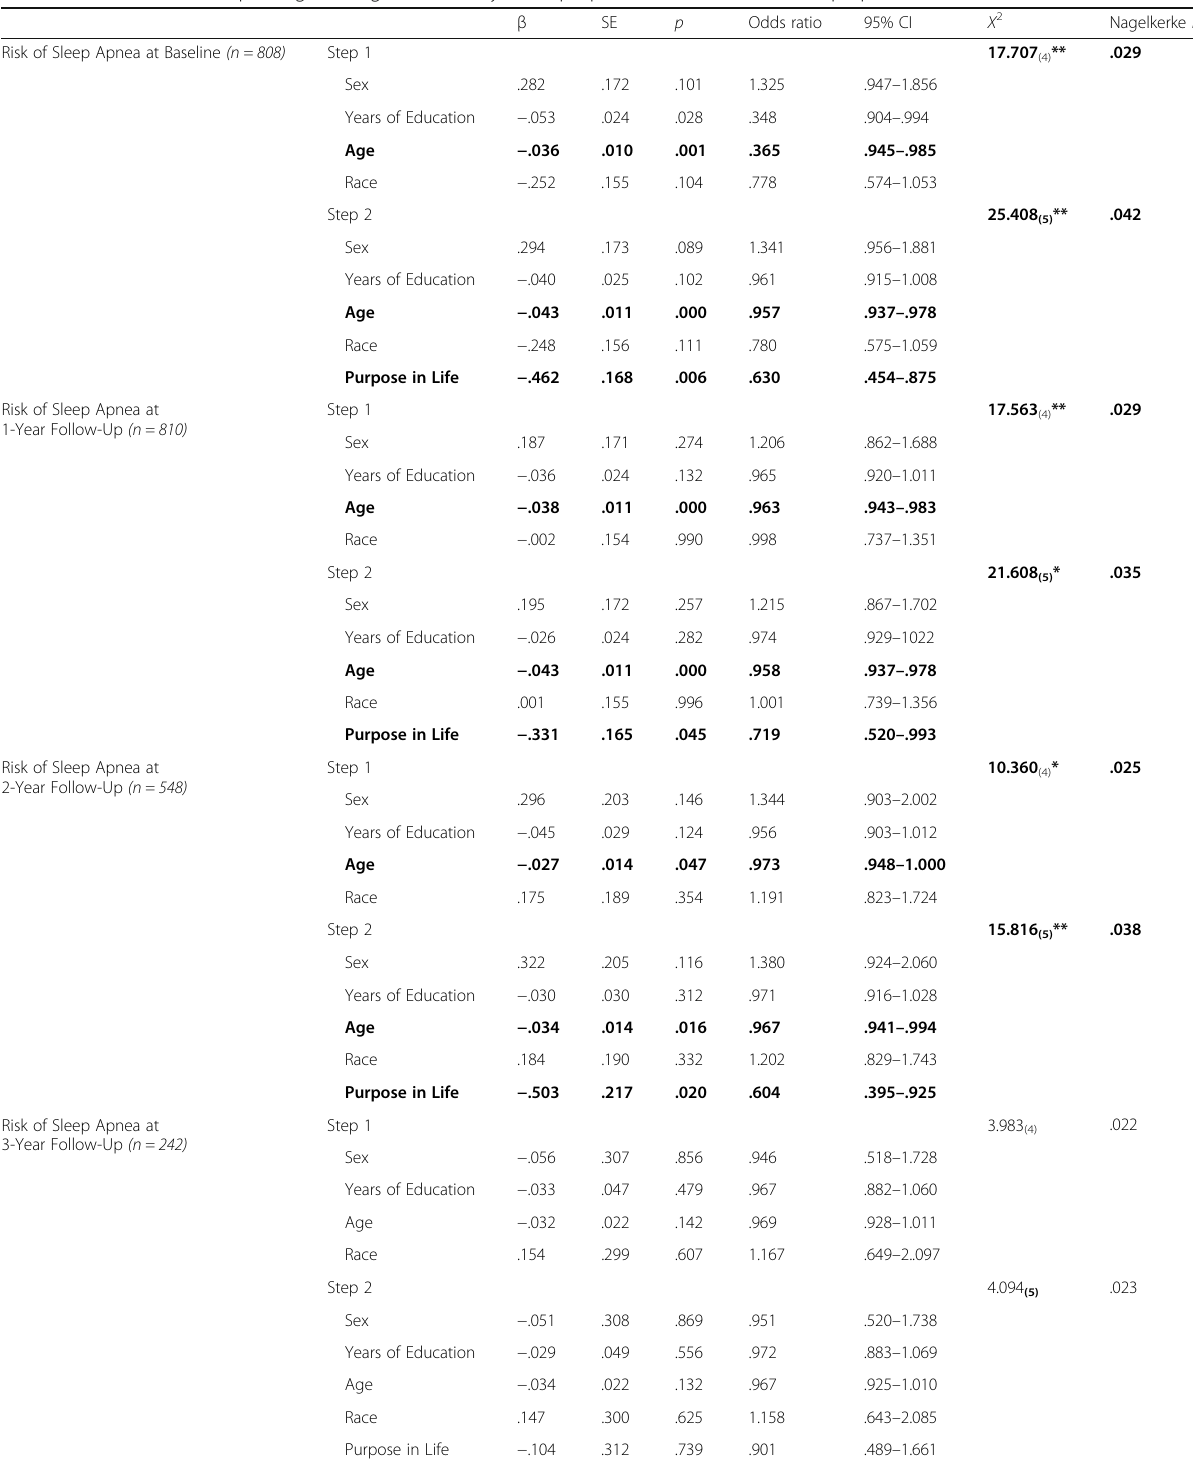
Table 3 Hierarchical Multiple Logistic Regression Analyses of purpose in life and risk of sleep apnea β SE p Odds ratio 95% CI Χ 2 Nagelkerke R 2 Risk of Sleep Apnea at Baseline